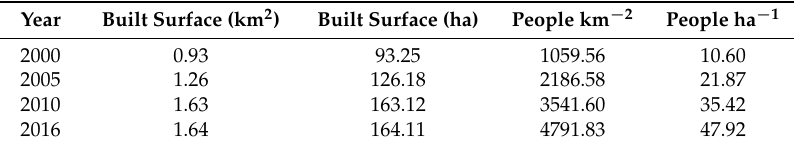
Table 3. Evolution of the population density of Altorreal urbanization.